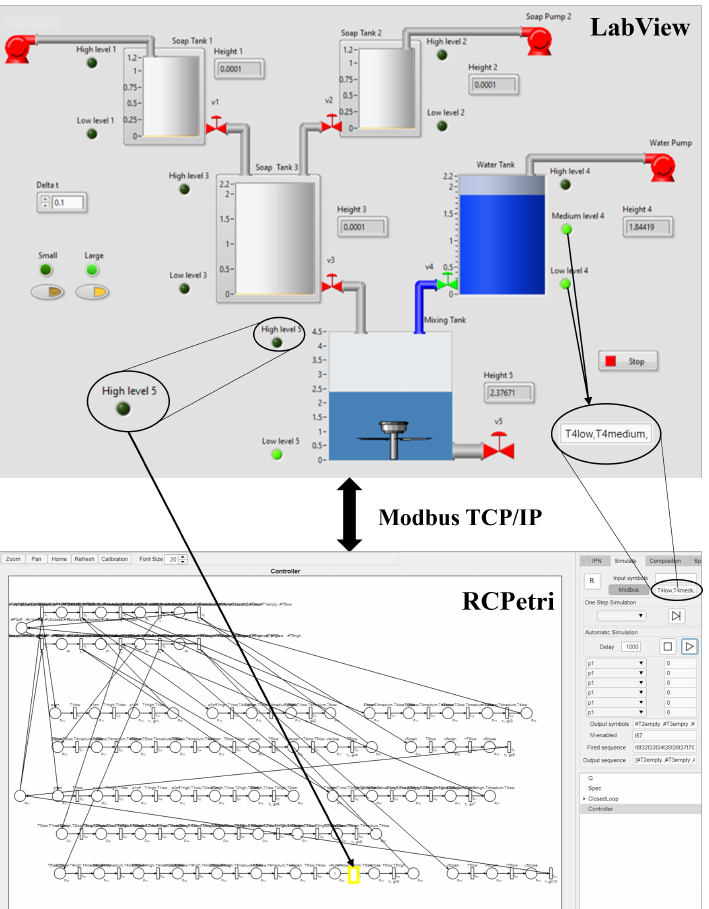
Figure 12. Simulation and control of the tank filling process. When the high-level sensor LT2-105 is activated, it will send a signal for the enabled transition to be fired. On the other hand, in the “Simulation Tab” the user can see the output symbols present in the